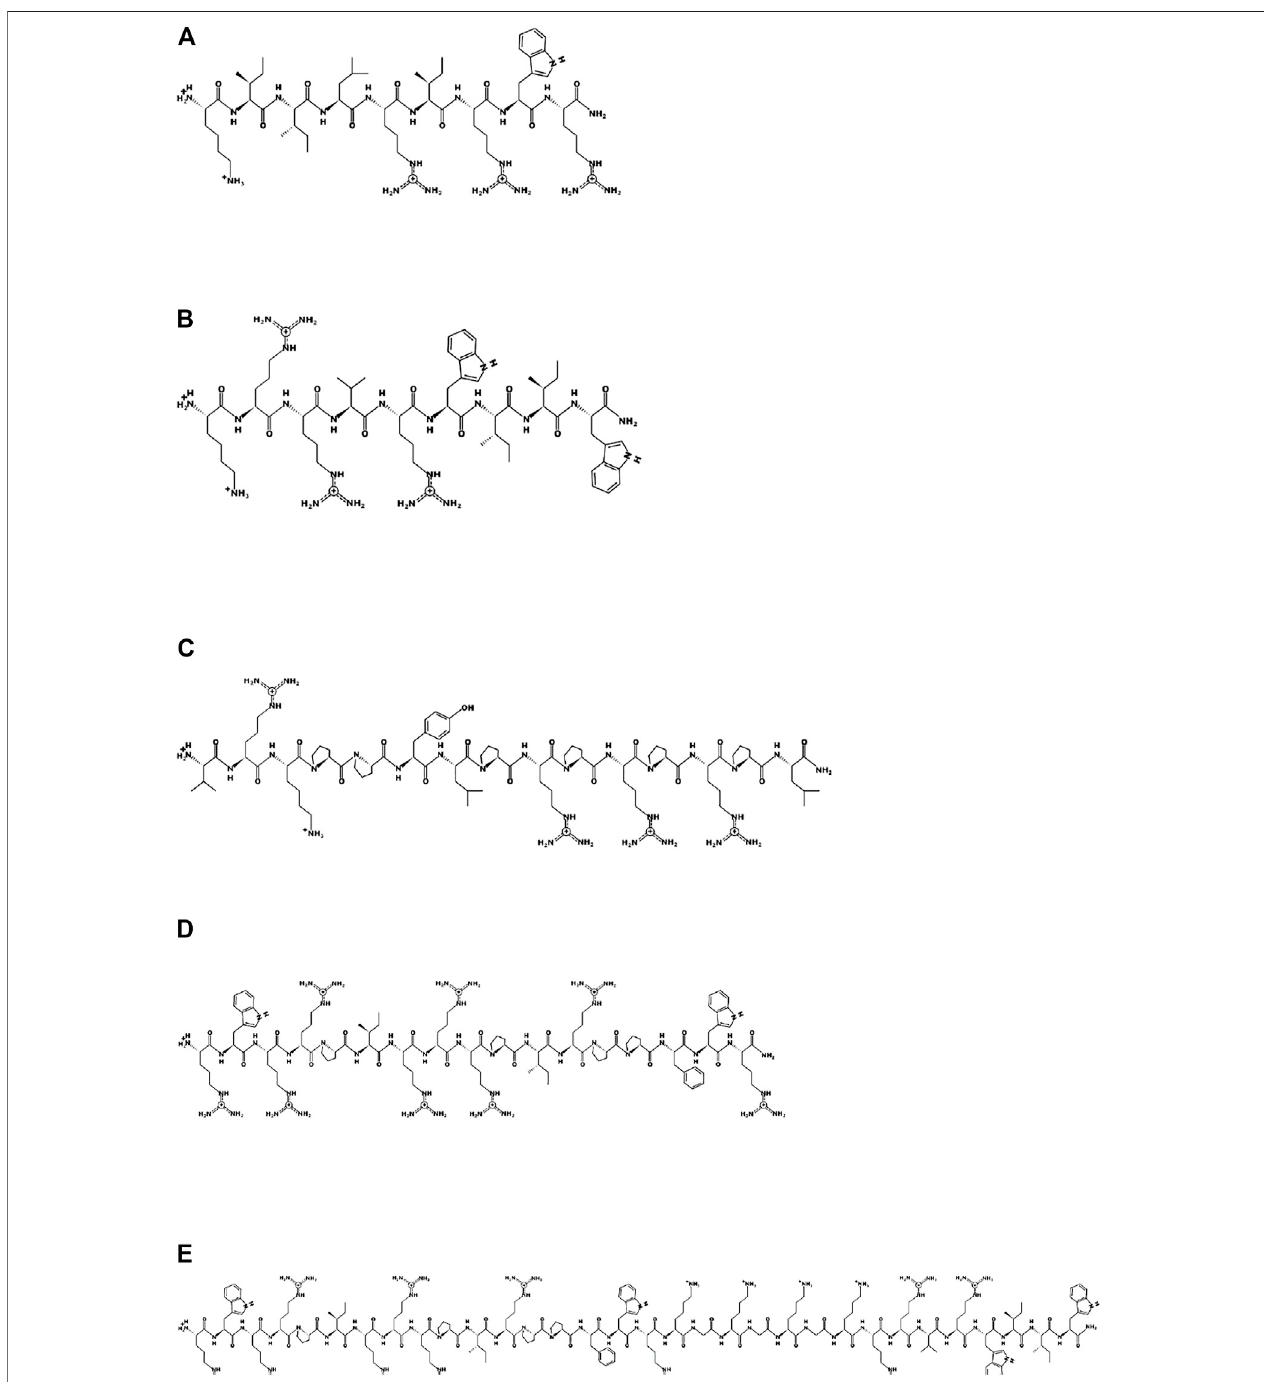
FIGURE2| SchematicrepresentationoftheparentpeptidesandonehybridpeptideusingtheprogramPEPDRAW(http://pepdraw.com/). (A) optP1,KIILRIRWR- CONH 2 , (B) optP7, KRRVRWIIW-CONH 2 , (C) consP1, VRKPPYLPRPRPRPL-CONH 2 , (D) Bac5-v291, RWRRPIRRRPIRPPFWR-CONH 2 , (E) hyP7B5GK, RWRRPIRRRPIRPPFWRKGKGKGKRRVRWIIW-CONH 2 .